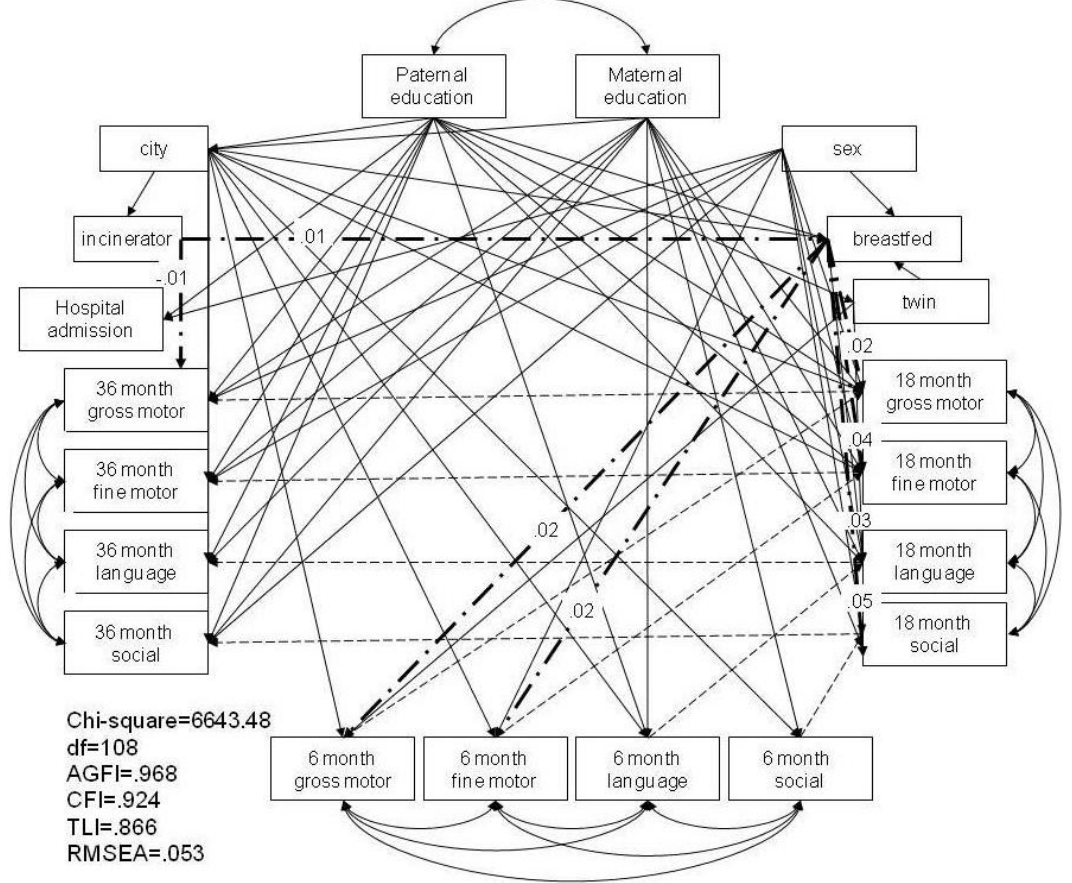
Supplementary Figure. Parsimonious pathway analysis models of the relationship pathways among parental level of education, place of residence, living near an incinerator, breastfeeding, hospital admission and child development at six, 18 and 36 months of